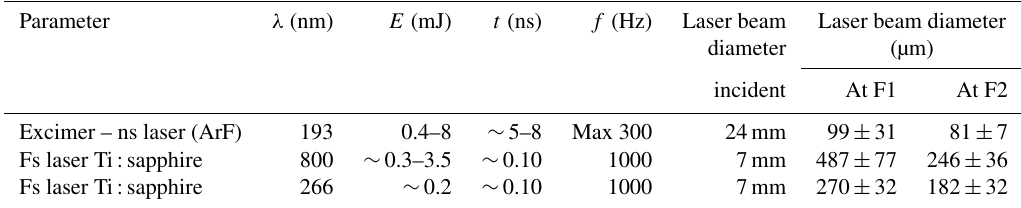
Table 1. Parameters of the ns and fs lasers: λ is wavelength, E is energy per pulse, and τ is pulse duration. Beam diameters before focusing lens and at the two interaction positions F1 and F2.